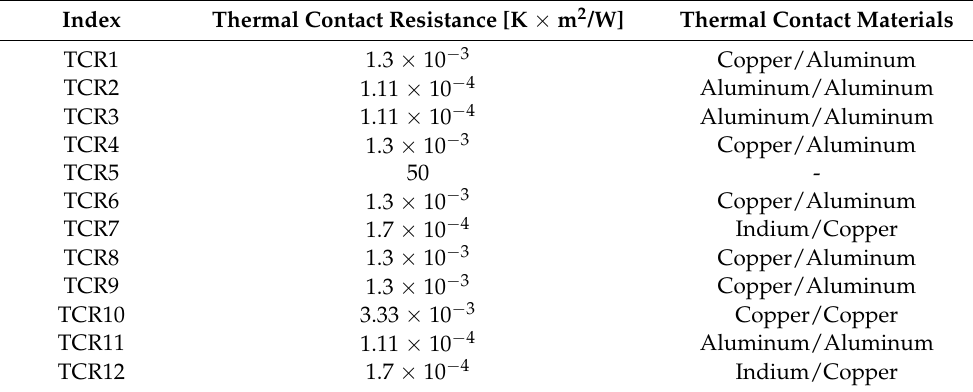
Table 3. Estimated Thermal Contact Resistance for the FEM